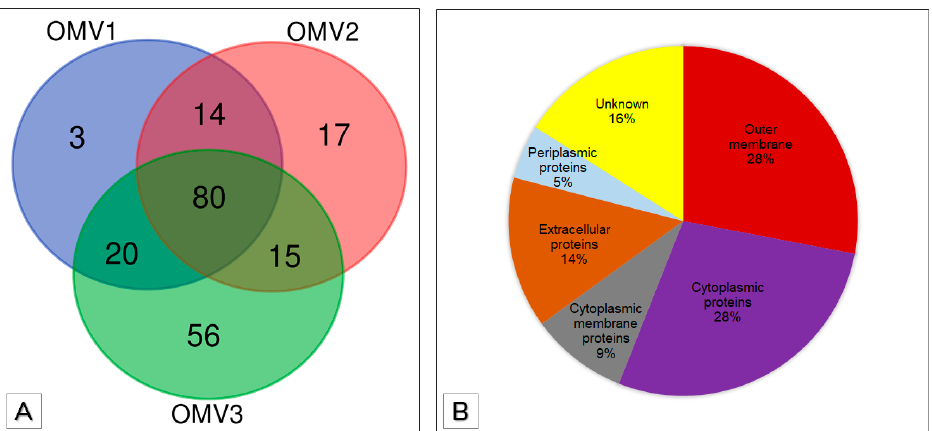
Figure 4. Shared and exclusive OMV-associated proteins of biological replicates and shared protein localization predictions. ( A ) The Venn diagram indicates shared and exclusive proteins of the three biological replicate OMVs isolated from Pbr1692 cultures. Eighty proteins were found present in all three biological replicates. ( B ) The pie chart shows the percentages of shared OMV proteins’ predicted localizations.